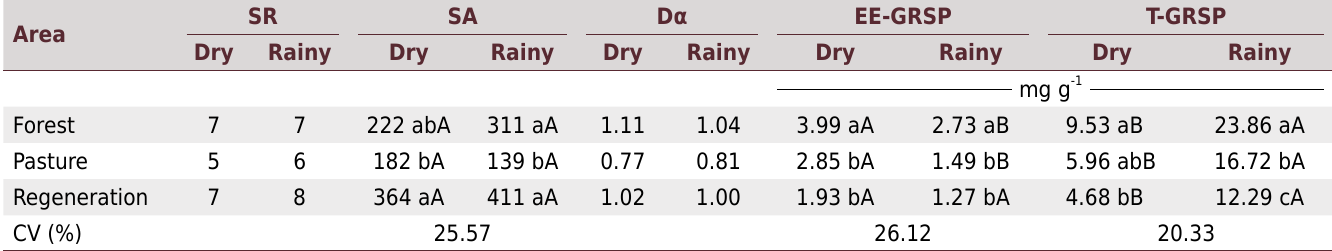
Table 5. Total species richness (SR) and spore abundance (SA) of arbuscular mycorrhizal fungi (in 50 cm -3 soil), Margalef index (Dα), easily extractable (EE-GRSP) and total (T-GRSP) glomalin-related soil protein in topsoil (0.00-0.05 m) sampled in the rainy and dry season in forest, pasture, and natural regeneration areas on the Palmital farm in Passa Vinte, MG, Brazil